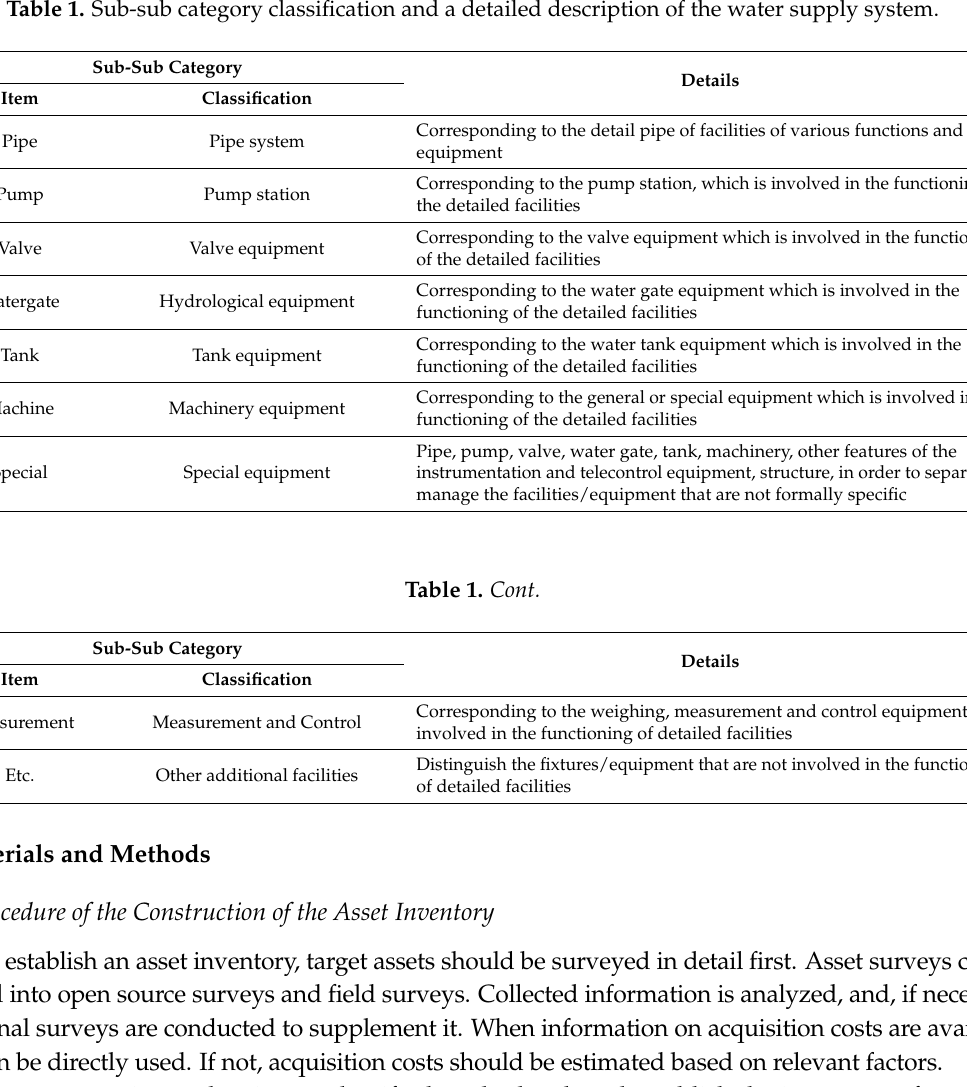
Table 1. Sub-sub category classification and a detailed description of the water supply